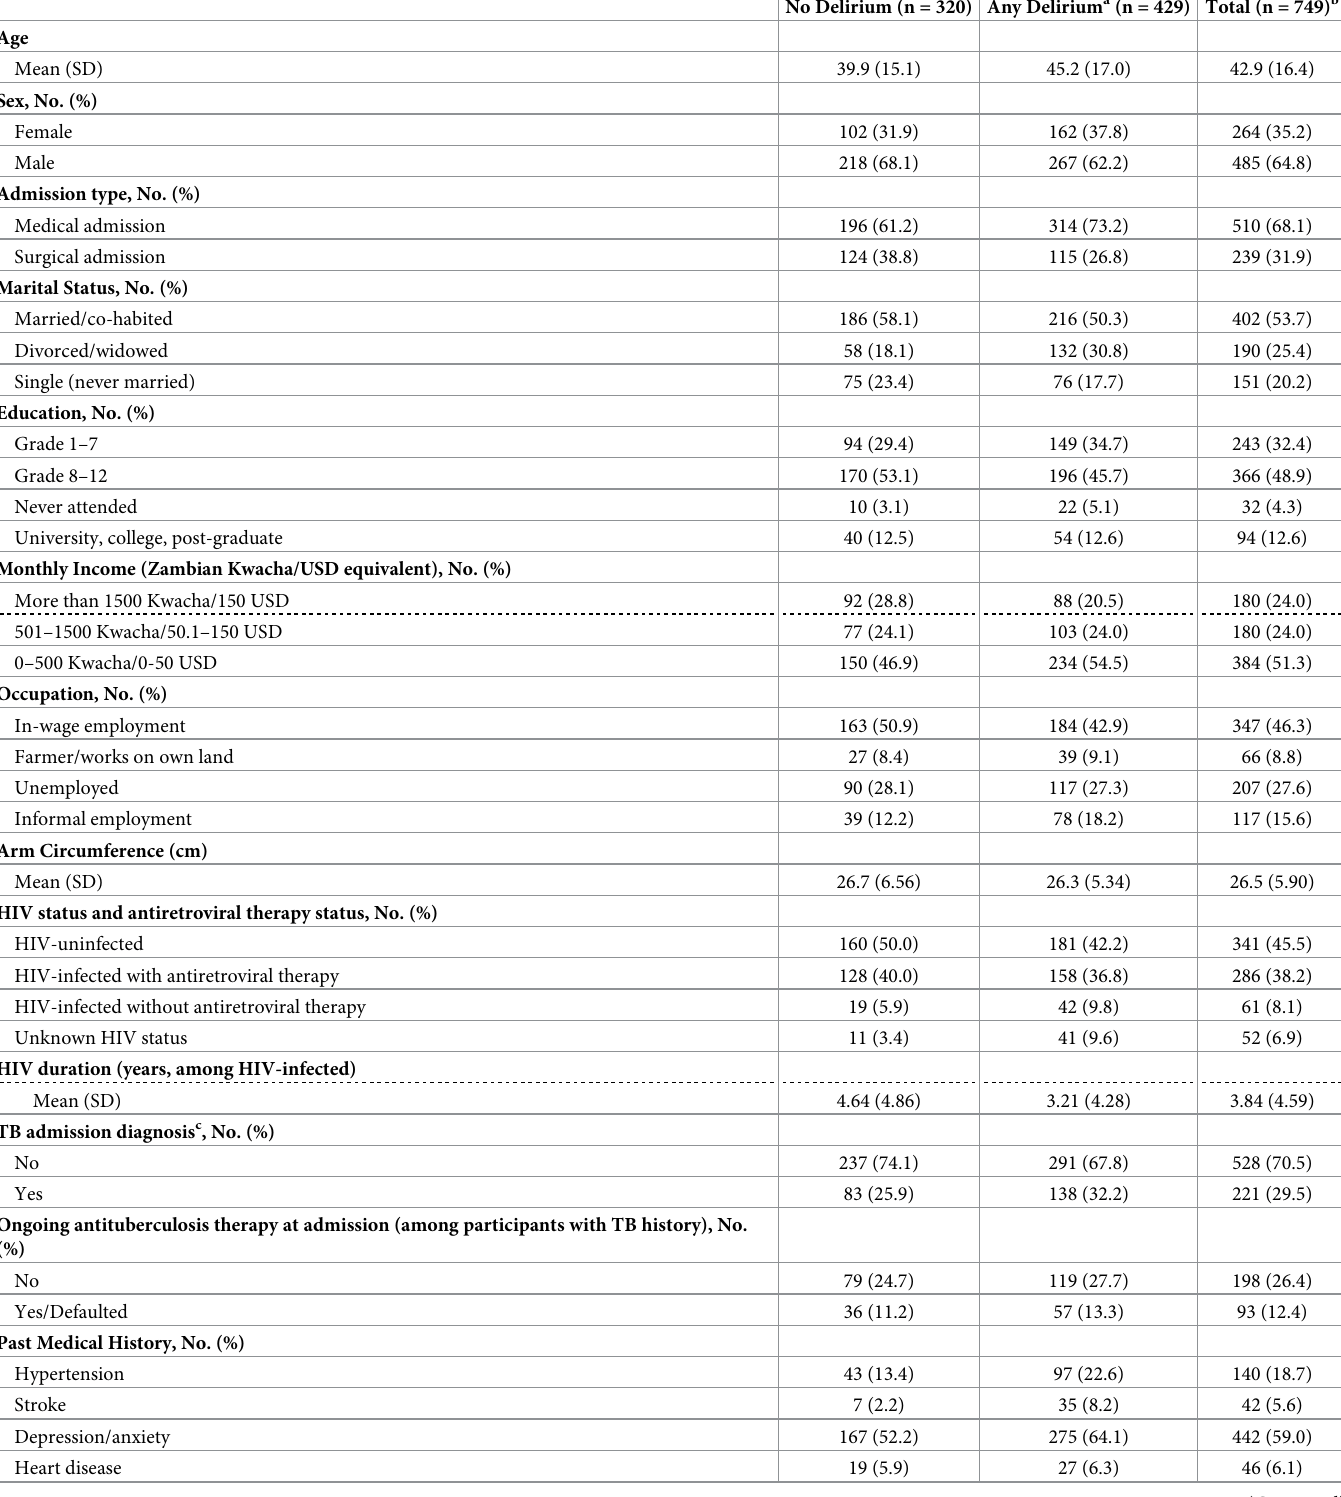
Table 1. Baseline characteristics of participants by delirium